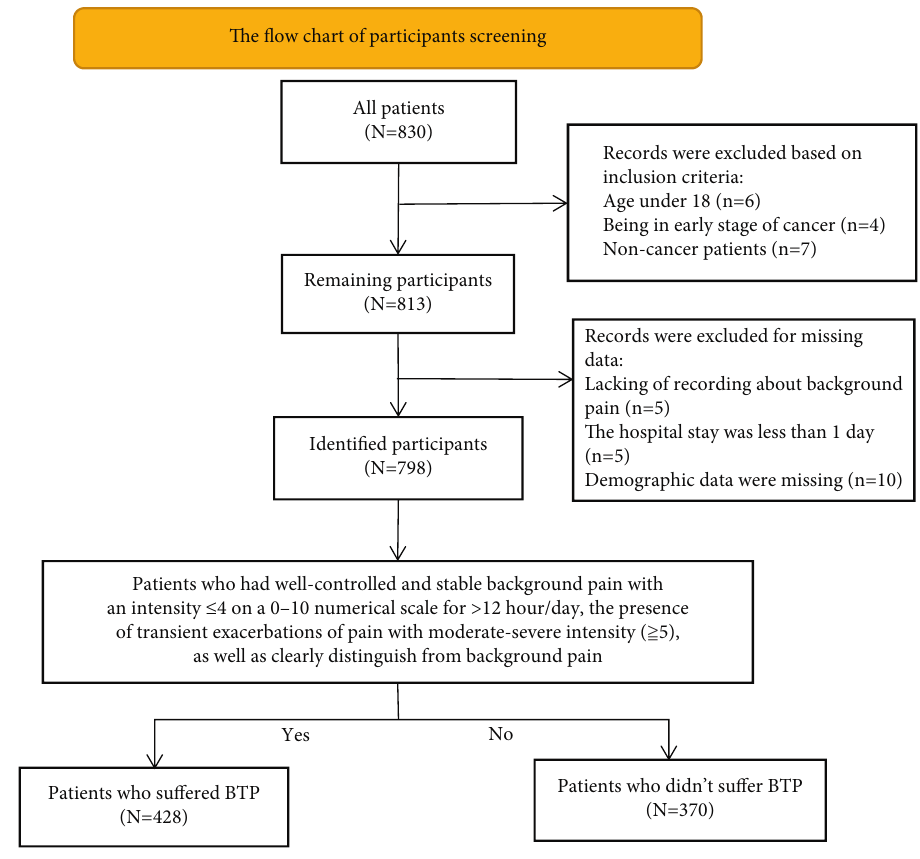
Figure 1: The flowchart of participants’ screening. Table 1: Demographic, clinical, and pain data characteristics of patients ( n �